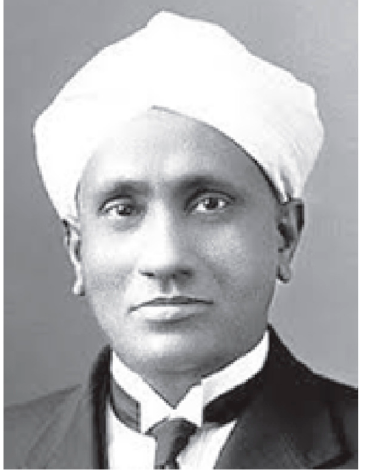
Figure 7. C.V. Raman .